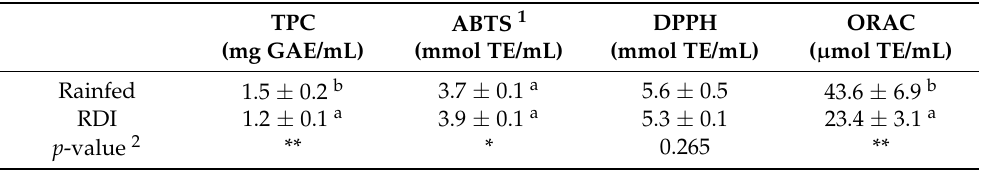
Table 5. Total phenolic content (TPC) and free radical scavenging activities (ABTS, DPPH, and ORAC) of Monastrell grapes under non-irrigation (rainfed) and regulated deficit irrigation (RDI)